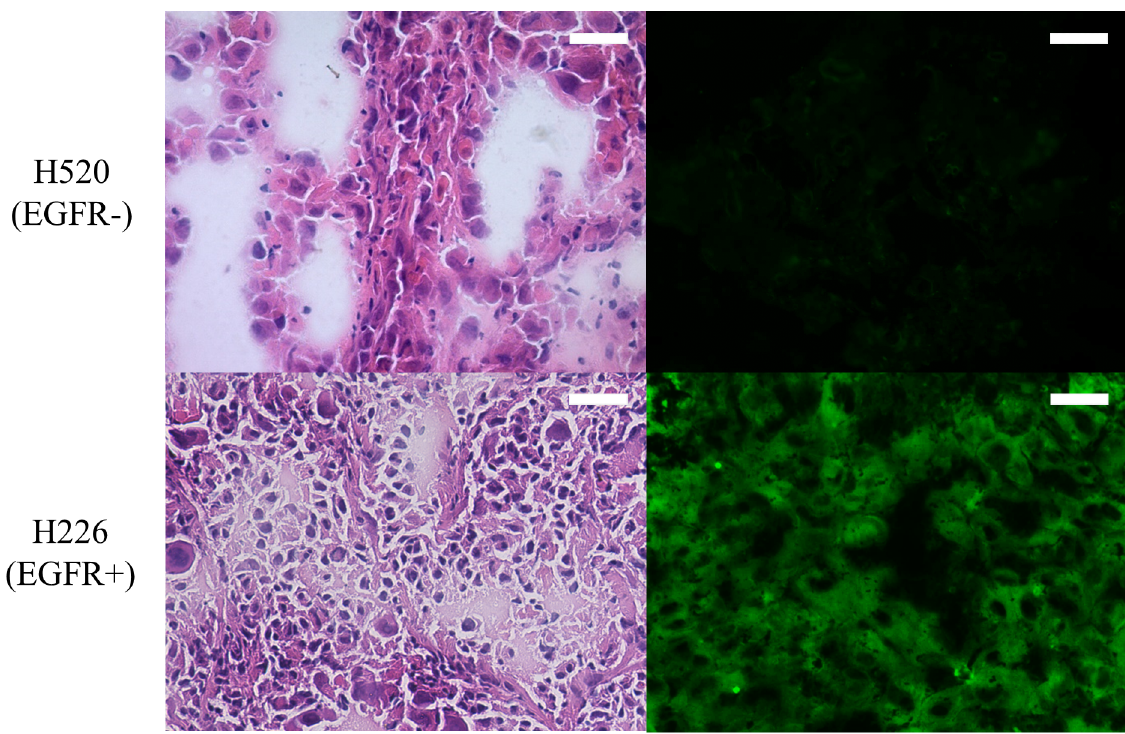
Fig 8. Pathological and immunohistochemical examinations. Comparison of the HE staining (Left) and Pan-ICG staining (Right) between EGFR- and EGFR+ lymph node metastases. Scale bar indicates 20 μ m.